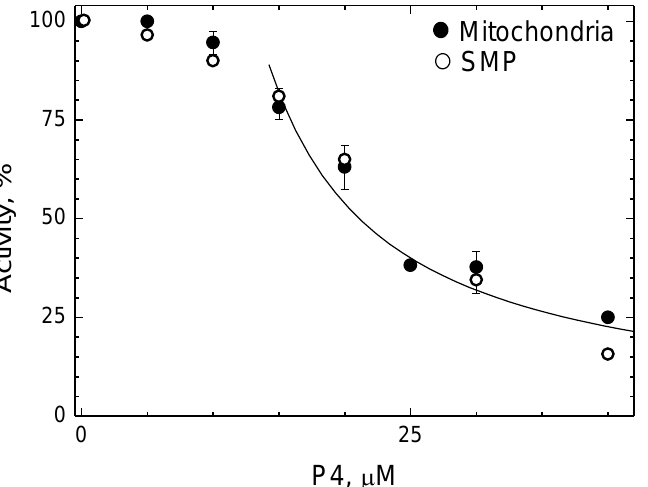
Figure 4. P4 inhibits CcO incorporated into the mitochondrial membrane. Rat liver mitochondria (closed symbols) or Keilin–Hartri particles from bovine hearts (SMP, open symbols) were suspended in the medium containing 0.3 M sucrose, 50 mM Hepes/Tris pH 7.6, 0.5 mM EDTA and 0.5 µ M CCCP up to 0.8 mg of protein/mL. Otherwise, the oxidase reaction was carried out and registered as in Figure 1. An approximating hyperbolic function (1) is drawn through the experimental points in the range of 14–45 µ M.